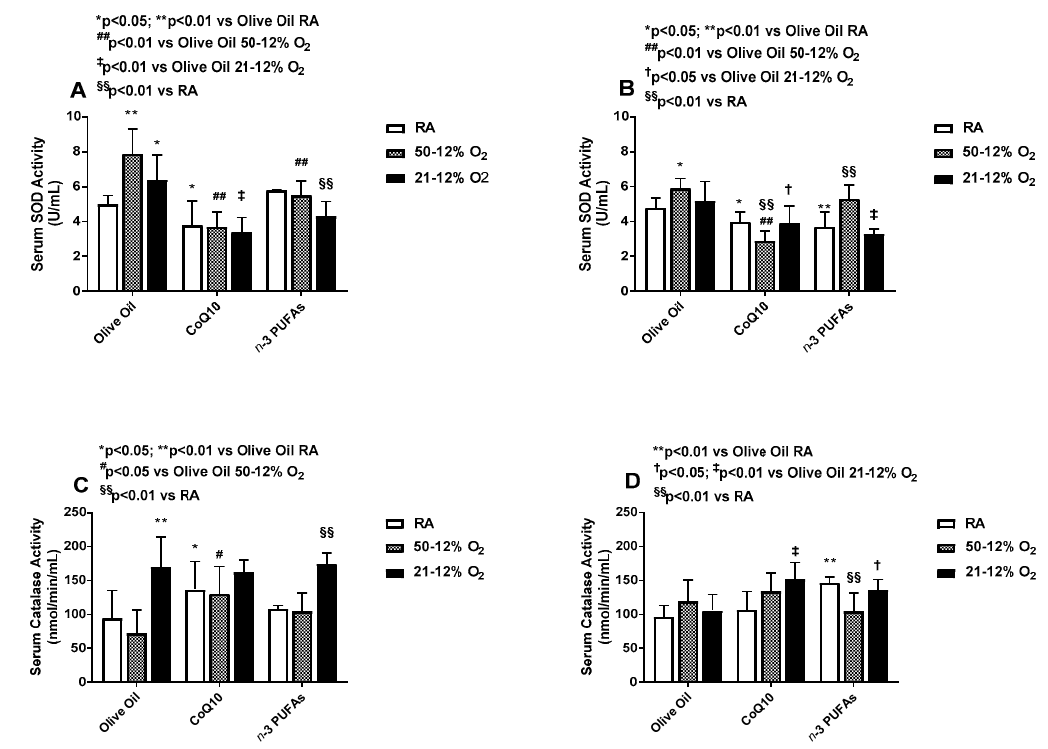
Figure 7. Effects of neonatal IH with Co-Q10 or n -3 PUFA supplementation on serum superoxide dismutase panels ( A , B ) and catalase panels ( C , D ) activities. Groups are as described in Figure 2. Data are expressed as mean ± SD ( n = 8 samples/group).